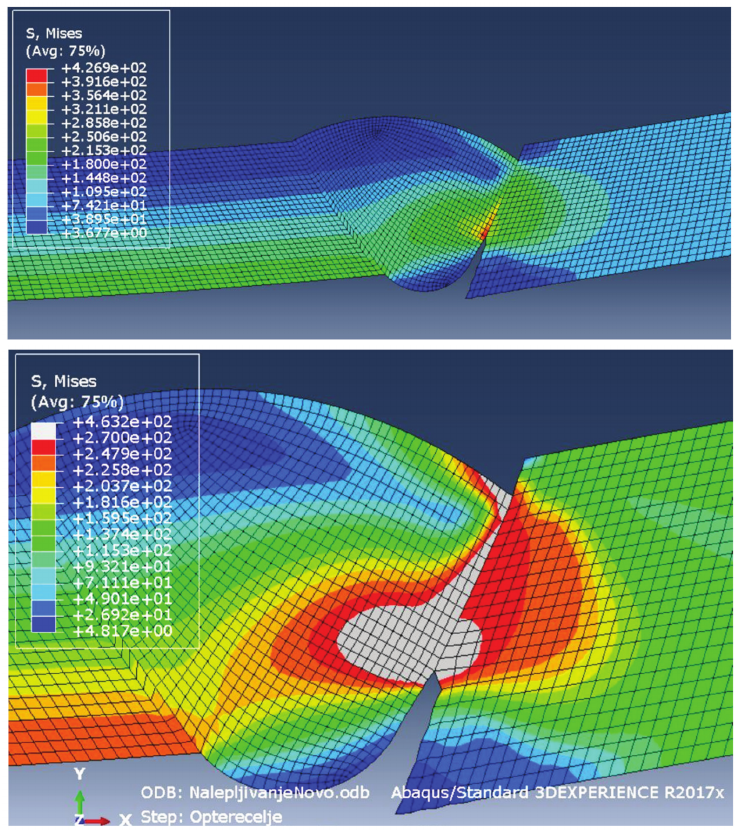
Figure 20. Stress distribution with a tensile load of 100 MPa ( top ) and 120 MPa ( bottom